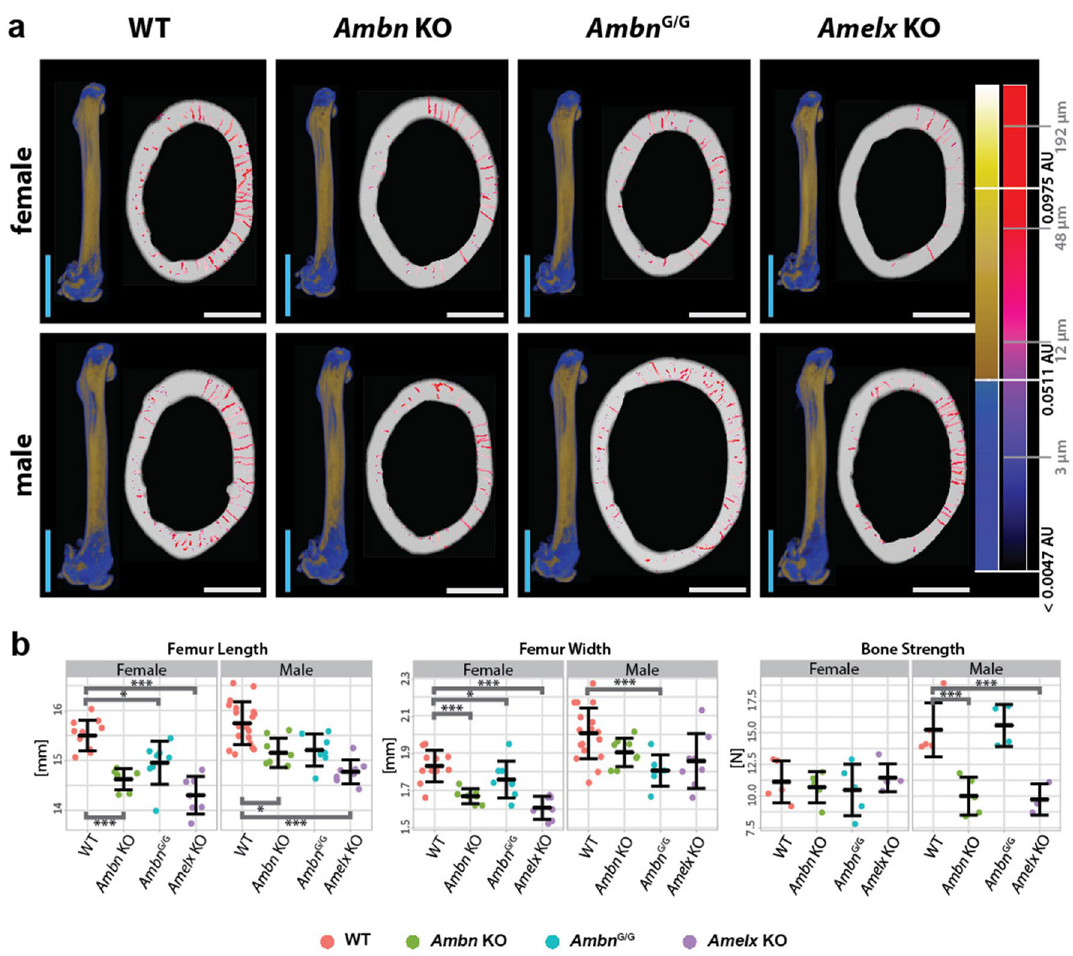
Figure 5. Long bone morphology and strength in Ambn and AmelX mutant mice. ( a ) Structure of femur— bone morphology (35 µm voxel resolution) on the left and porosity of the cortical bone (1.5 µm voxel resolution) on the right. Pseudo colors correspond to differences in mineralization in the whole femur (blue– yellow spectrum), or the pore size in the section (violet–red spectrum). Blue vertical bar (whole femur) = 2 mm, white horizontal bar (section with pores) = 0.5 mm. ( b ) Whisker plots of femur morphometry and bone fracture analysis characteristics: femur length, femur width (both in mm), and bone strength (in Newtons, N). Females on the left and males on the right of each graph. Thick midline = mean, whiskers = standard deviation; *< 0.05, ***< 0.001. Values for each observation are shown as points—WTs in red, Ambn KO in green, Ambn G/G in blue, and Amelx KO in